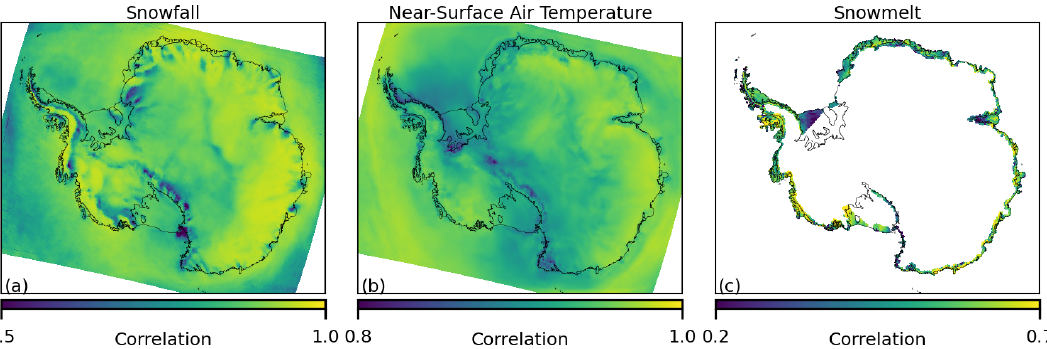
Figure 3. The median correlation by grid cell in the residual component of the monthly time series between the 28 unique model pairs for snowfall (a ), near-surface air temperature (b) and melt (c) . The colour scale relates to the value of correlation, and the scale/limits are adjusted for each